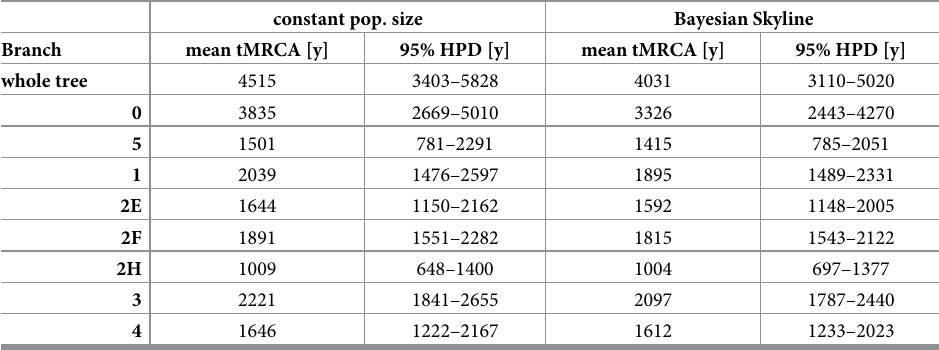
Table 2. Time to the most recent common ancestor (tMRCAs) for the entire M . leprae tree and individual branches (HPD = Highest Posterior Density). constant pop.